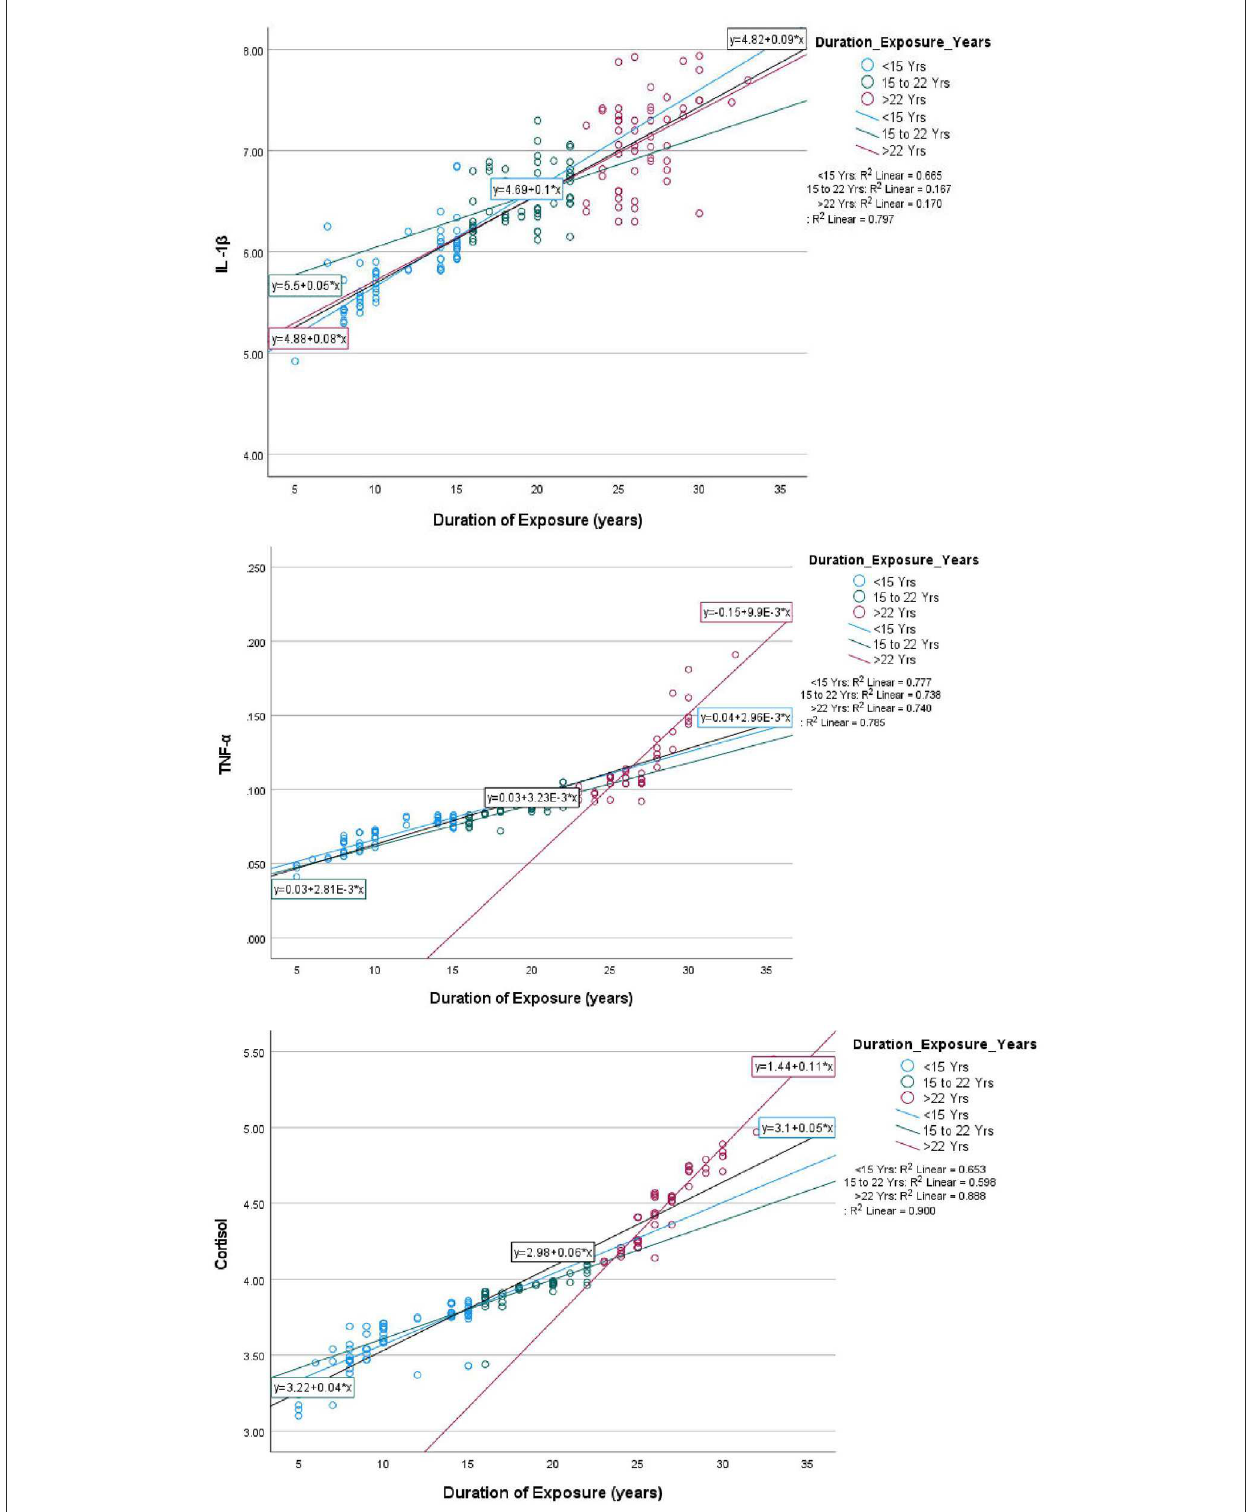
FIGURE5 Linear regression between duration of exposure and levels of various inflammatory biomarkers (CRP, IL-6, IL1- β , TNF- α and cortisol) among exposed farm-workers ( n = 180).